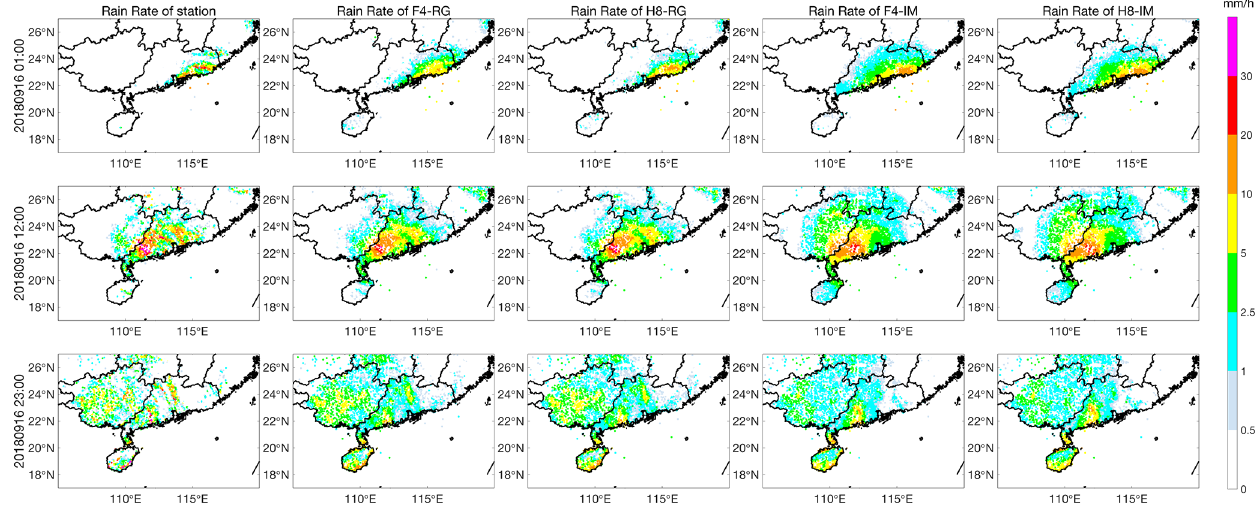
Figure 7. Comparison of the hourly precipitation from the ground rain-gauge observations with the F4-RG, H8-RG, F4-IM and H8-IM estimates at instants steps (01:00UTC on 16 September 2018, 12:00UTC on 16 September 2018, and 23:00UTC on 17 September 2018).